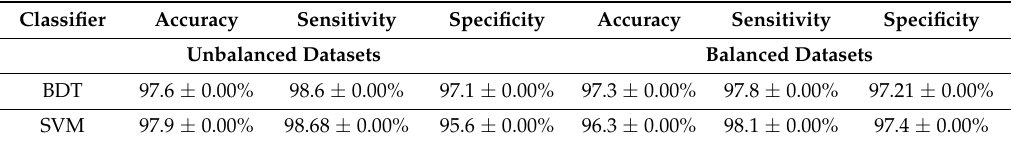
Table 7. Performance of stage 2: AF detection.